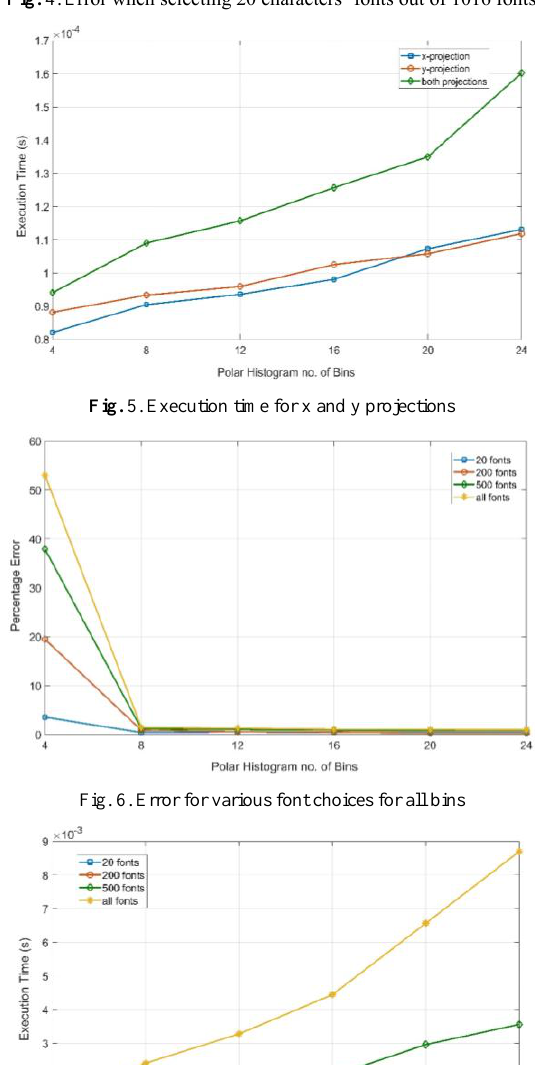
Fig. 4. Error when selecting 20 characters’ fonts out of 1016 fonts